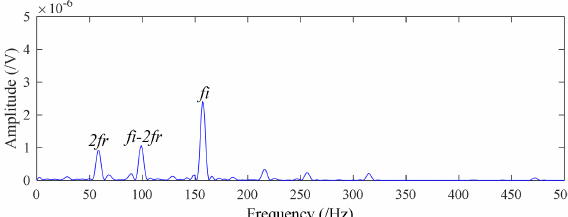
Figure 20. The diagonal slice spectrum after noise reduction using standard local projection.